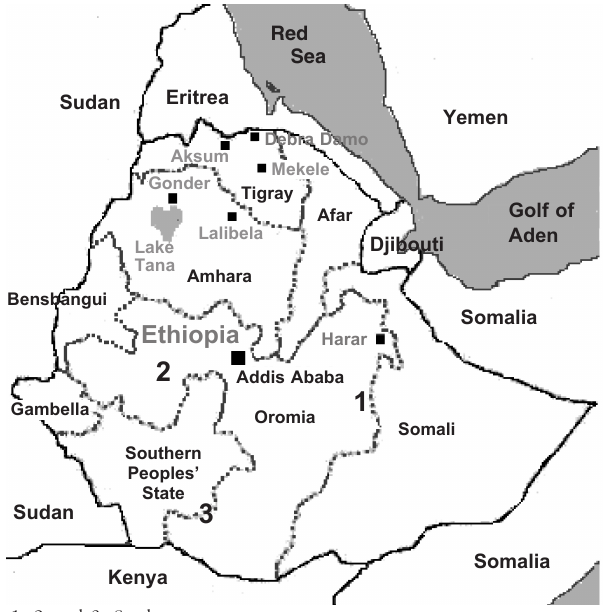
Fig. 1. – Map of Ethiopia showing study sites.